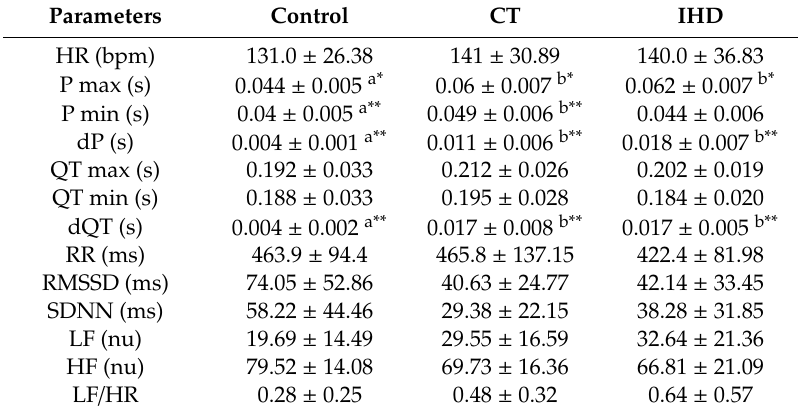
Table 5. Mean and standard deviation of the predictive parameters of arrhythmias and HRV indexes of the control group and of dogs with IRIS CKD Stage 4 after the third session of CT and IHD.